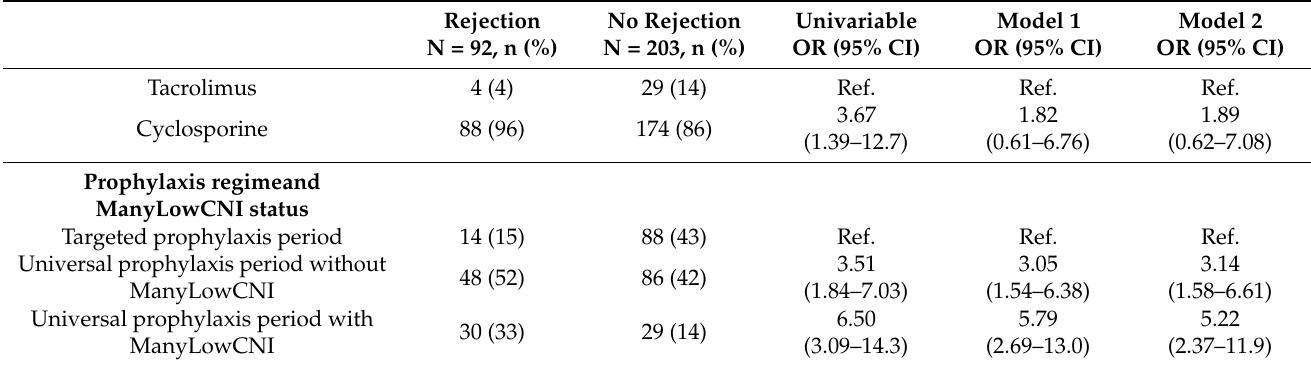
Table 3. Post hoc analyses on factors associated with acute